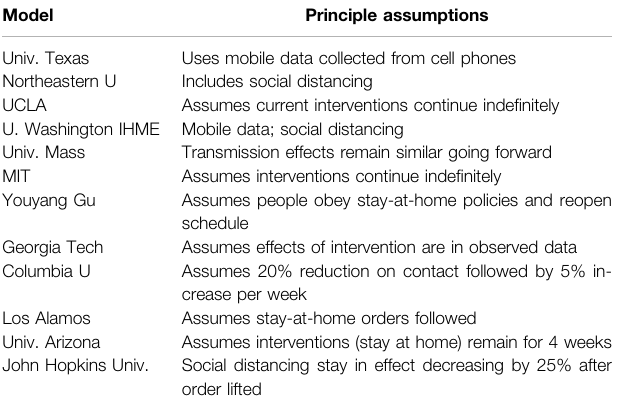
TABLE 1 | Summary of contemporary models in the fi ght against COVID-19.